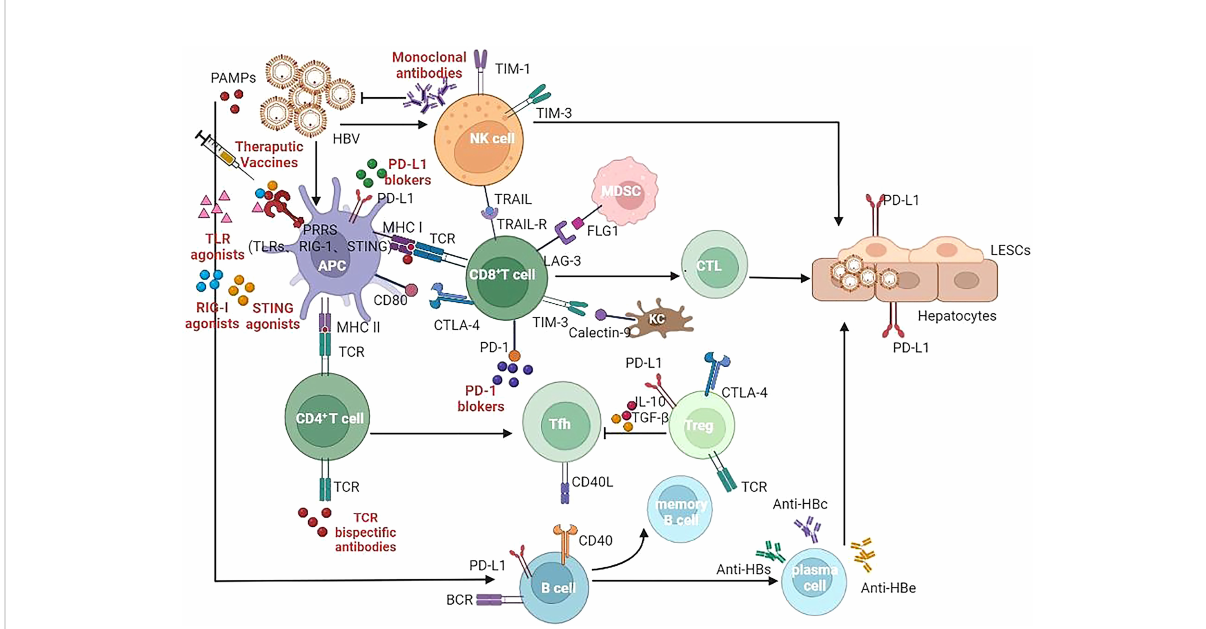
FIGURE 1 Target of immunomodulatory drugs in development for CHB infection. APC, Antigen presenting cells; NK, Natural killer (cells); MDSC, myeloid derived suppressor cells; CTL, cytotoxic lymphocyte; Tfh, T follicular helper (cells); Treg, regulatory T cells; LSEC, liver sinusoidal endothelial cells; TLR, Toll-like receptor; RIG-I, Retinoic Acid Inducible Gene I Protein; STING, stimulator of interferon genes; TCR, T cell receptor; BCR, B cell receptor; MHC, major histocompatibility complex; CLTA-4, cytotoxic T lymphocyte-associated antigen-4; PD-1, programmed death -1; PD- L1, programmed death ligand-1; TIM-3, T-cell immunoglobulin domain and mucin domain-containing molecule-3; TRAIL, TNF-related apoptosis-inducing ligand; LAG-3, Lymphocyte-activation gene 3; FLG1, Fibrinogen Like Protein